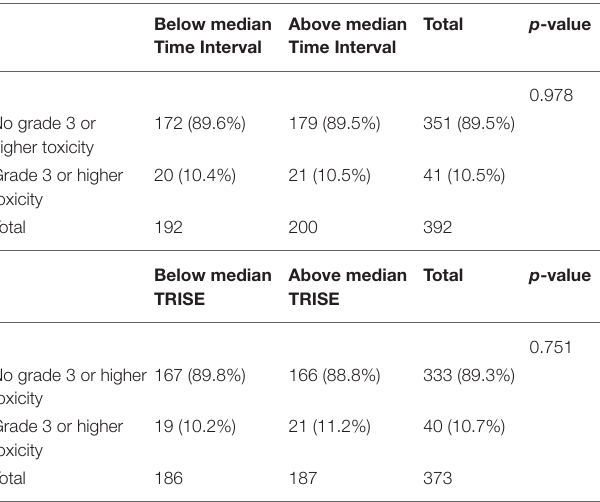
TABLE 4 | Comparison of late toxicity in low and high TRISE and low and high time interval